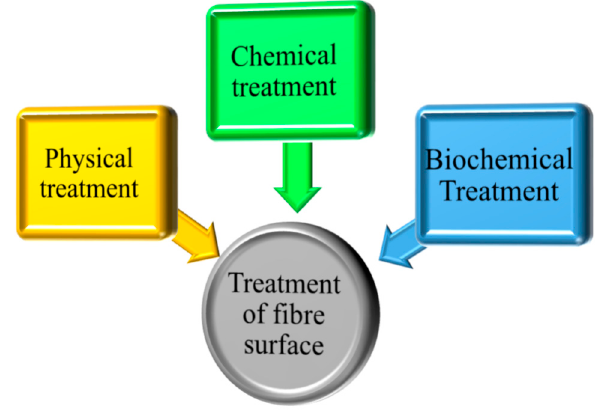
Figure 6. Fiber treatments via various techniques.